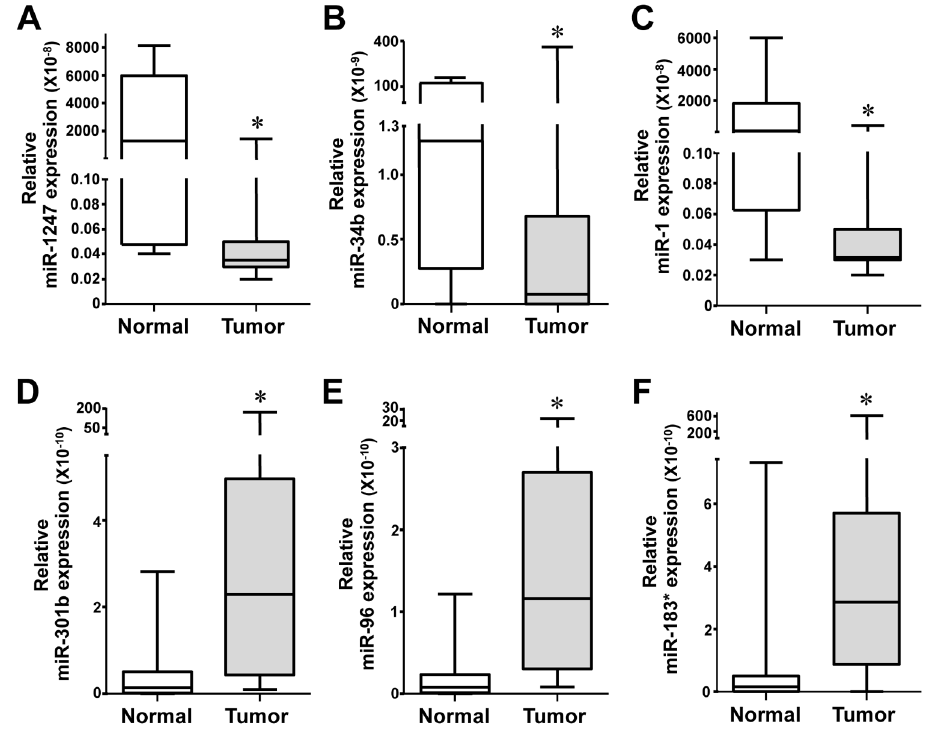
Figure 1. Overexpression or reduced expression of specific miRNA in stage I lung adenocarcinoma. miRNA expression for the indicated miRNA was determined by TaqMan qPCR array in individual patient samples of lung adenocarcinoma (n=20) and adjacent normal lung tissue (n=14). D Ct values graphed are relative to RNU48, an endogenous small RNA control. The box represents the first and third quartiles and the horizontal line within the box is the median. Whiskers represent the maximum and minimum values. *p values listed in Table 2A.